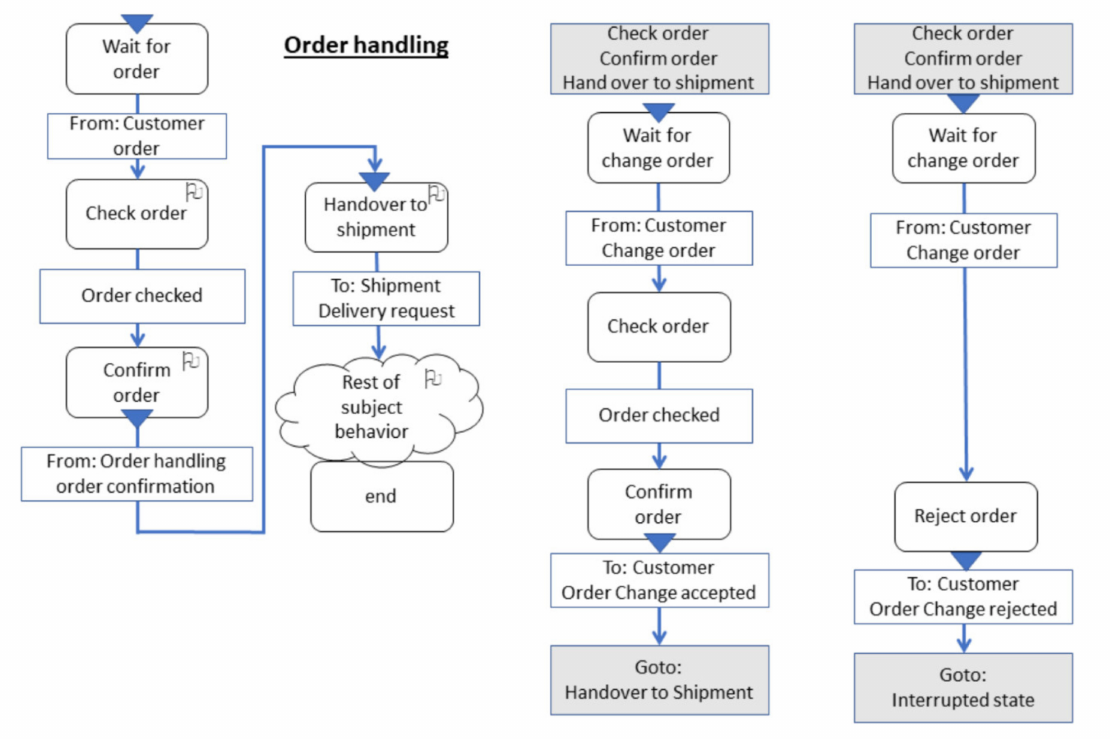
Figure 9. Order Handling Subject Behavior Diagram (SBD) including a change of